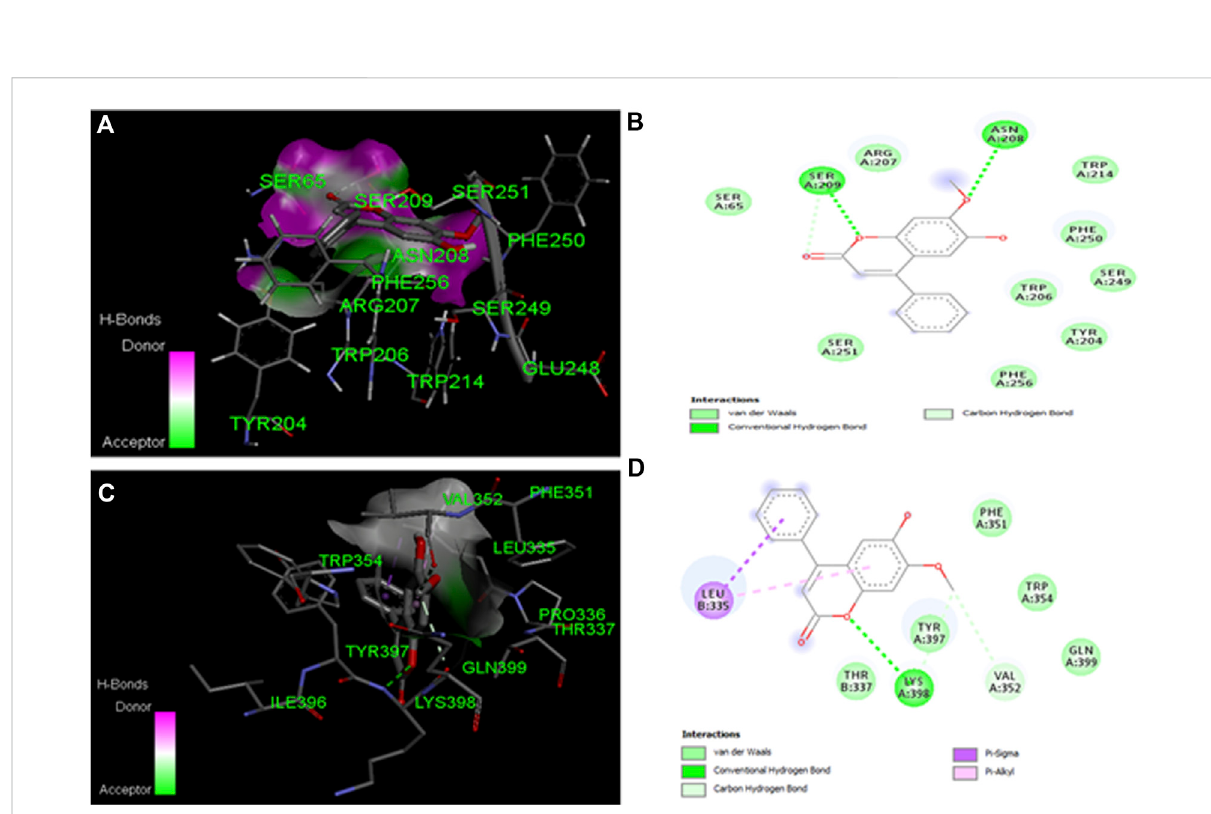
FIGURE 8 Molecular docking studies of dalbergin with caspage-3 and 9. (A) The output of AutoDock 3D diagram shows the binding site residues of caspase-3 with the dalbergin, with binding af fi nity of − 6.7 kcal/mol. (B) The 2D structure exhibits different types of interactions formed between caspase-3 and dalbergin. The dark green and purple dotted lines indicate H-bond interactions between caspage-3. (C) The output of AutoDock 3D diagram shows the binding site residues of caspase-9 with the dalbergin, with binding af fi nity of − 6.6 kcal/mol. (D) The 21:1 structure exhibits different types of interactions formed between caspase-9 and dalbergin. The dark green and purple dotted lines indicate H-bond and Pi-Sigma interactions between caspage-9 and